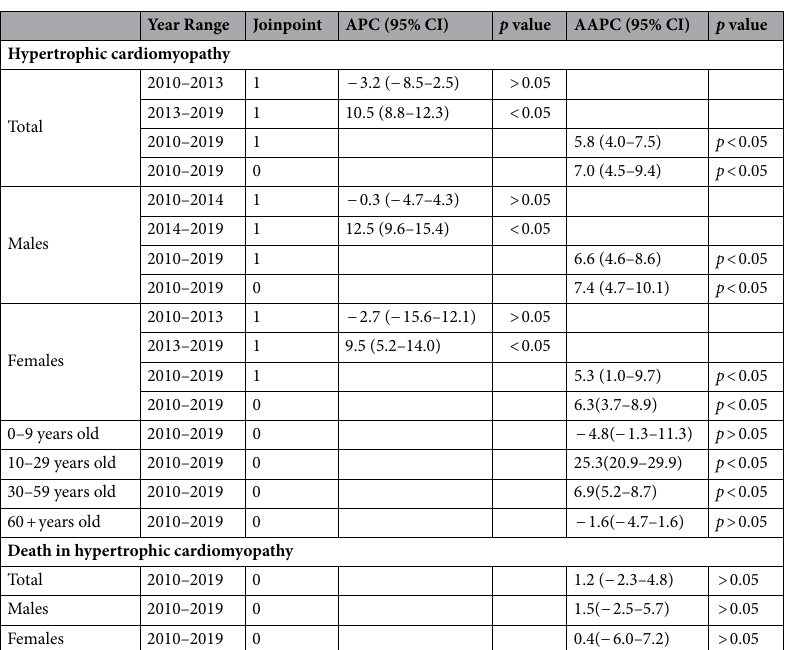
Year Range Joinpoint APC (95% CI) p value AAPC (95% CI) p